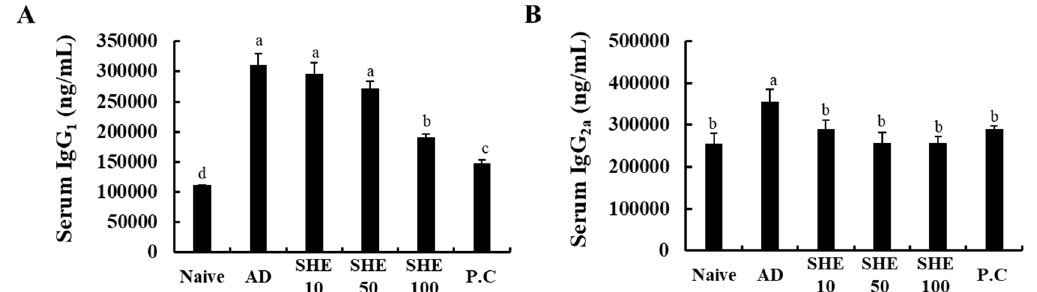
Figure 3. Evaluation of the serum levels of immunoglobulins in HDM / DNCB-induced mice. ( A ) Serum IgG 1 ; and ( B ) IgG 2a levels of HDM / DNCB-induced mice, orally administered with SHE. Experiments were performed in triplicate, and the data were expressed as mean ± SD. a–d Values with di ff erent alphabets were significantly di ff erent at p < 0.05 ( n = 8).